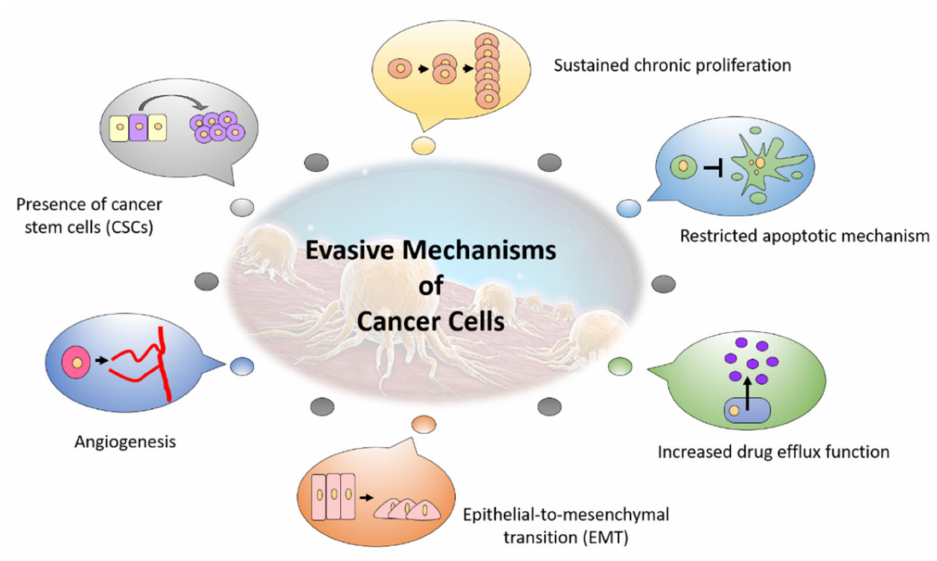
Figure 1. The evasive mechanisms developed by cancer cells in response to cancer